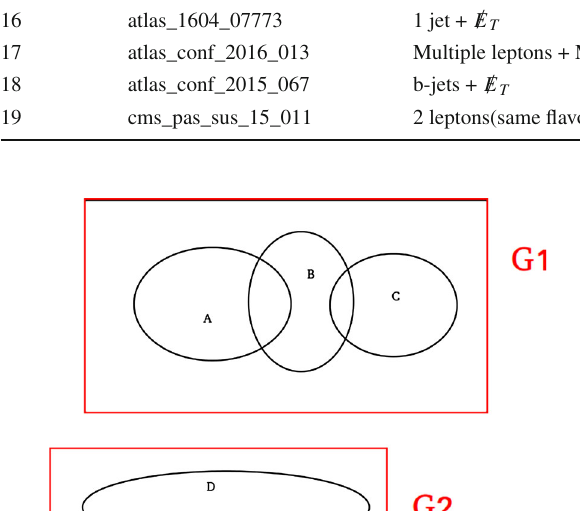
and uncorrelated. for all sampled Figure 4a, b show the distributions of χ 2 CM points. Two peaks can be observed in both plots: the first ≈ peak, called the zero signal peak , is located at around χ 2 CM ≈ 54 (13 TeV, right plot), 40 (8 TeV, left plot) and χ 2 CM valuesinthezerosignalpeaksbelongto respectively.All χ 2 CM pMSSM-11 parameter points with very heavy SUSY spectra and thus very little or no expected signal in any of the SRs. A > second peak occurs at χ 2 = 100 because we set all χ 2 CM 100 to this value. This was done to avoid the neural networks > 100, where the model learning any structures at large χ 2 CM is already clearly excluded by the LHC data. The three regions labeled I, II and III outside of the zero = 100 in Fig. 4a, b are called signal peak and the peak at χ 2 CM rare target ranges . We differentiated between regions below (I) and above (II and III) the zero signal peak and